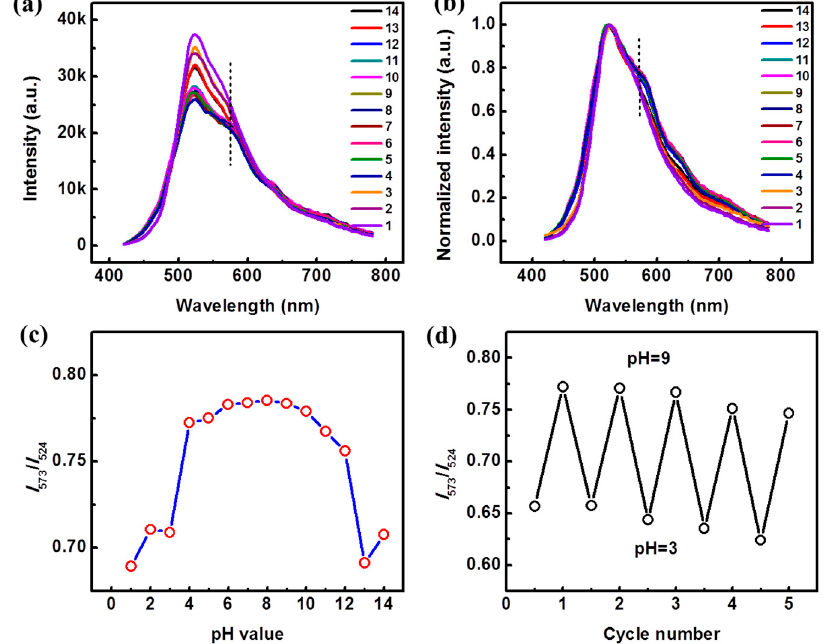
Figure 5. Fluorescence properties of Pdots-20% at various pH: ( a ) Fluorescence spectra; ( b ) Normalized fluorescence spectra; ( c ) Plot of the relative fluorescence intensity ratios ( I 573 / I 524 ) in response to pH values; ( d ) The intensity ratios ( I 573 / I 524 ) upon repeatedly switching pH between 3 and 9.